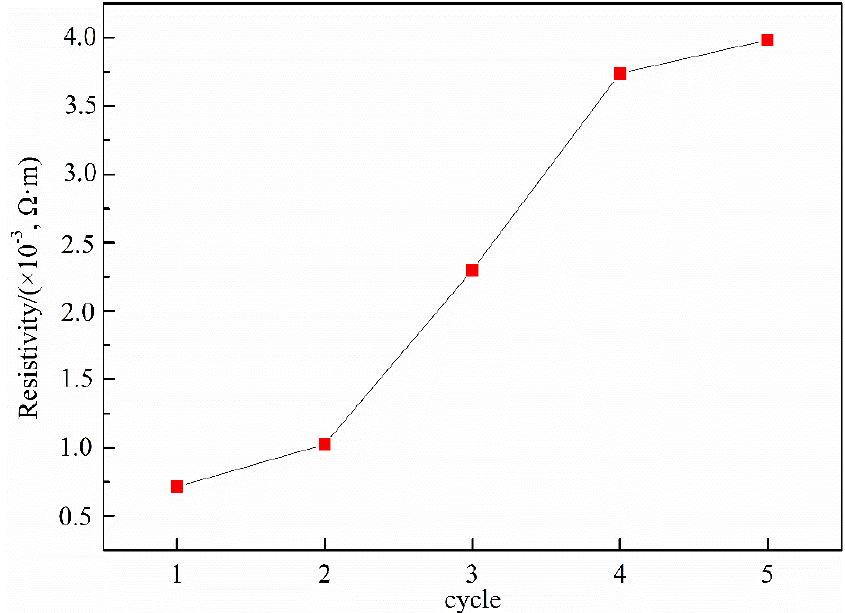
Figure 8. The coating resistivity of five electricity tests in the heat preservation stage.